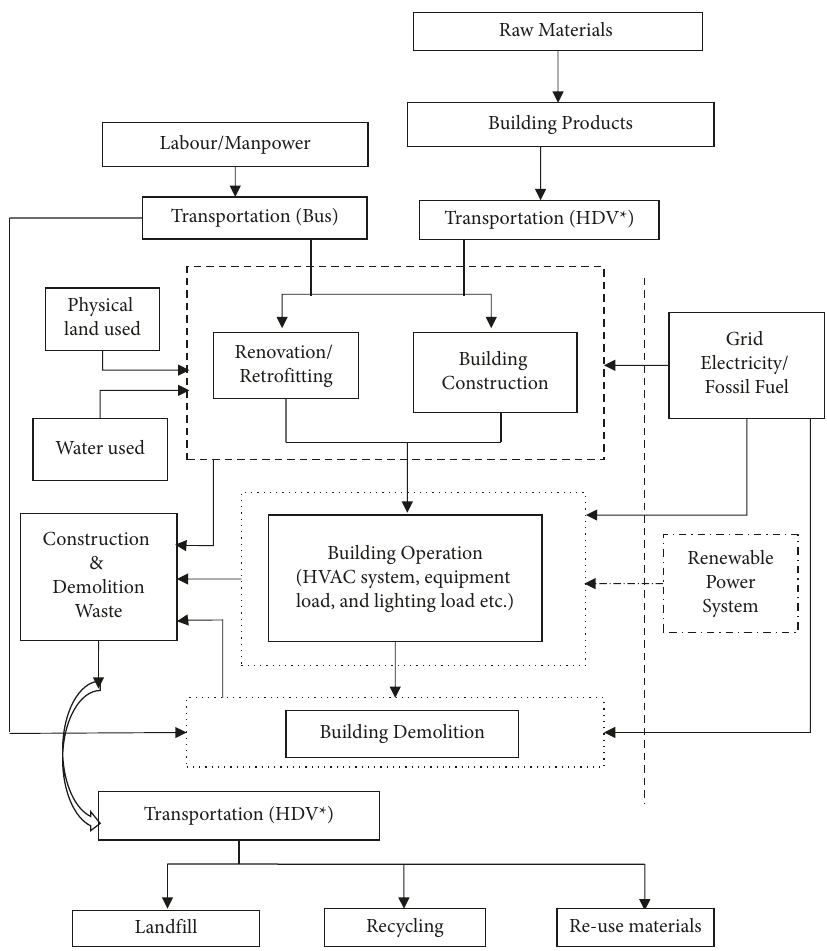
Figure 1: System boundary for the analysis of a building (self-made). ∗ Heavy-duty vehicle